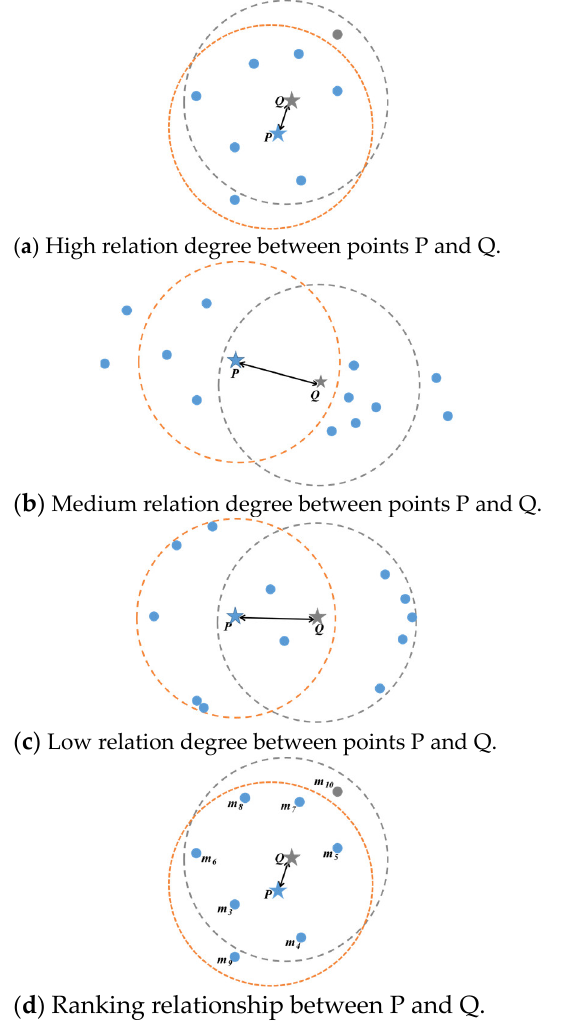
Figure 4. Relation degree between points P and Q when K = 9.